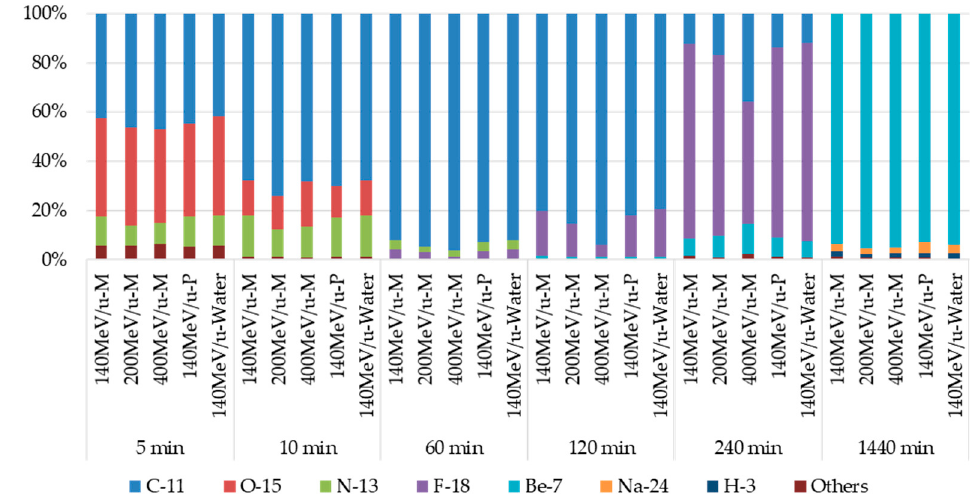
Figure 6. Simulation results of induced radionuclides and the ratio of their activities from 5 min to 24 h (1440 min) after irradiation. M and P denote a micellar gel specimen and a polymer gel specimen, respectively.